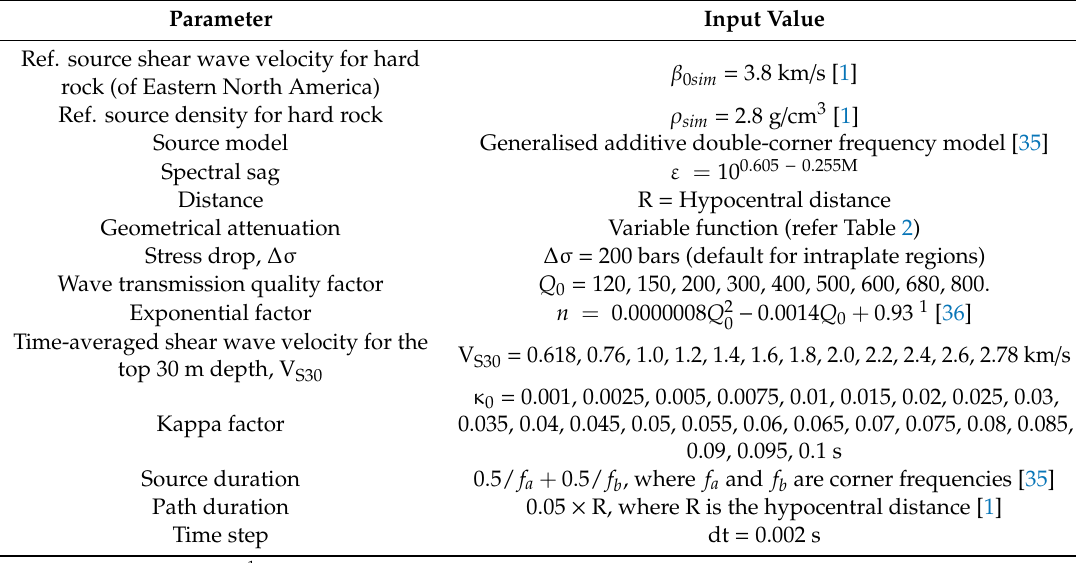
Table 1. Parameter values used in stochastic simulations for component attenuation model (CAM)